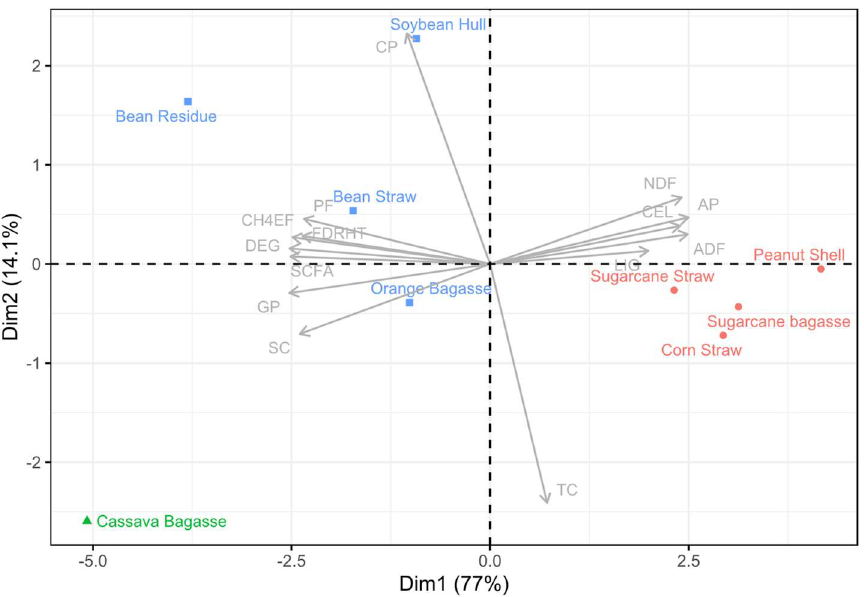
Figure 2. PCA showing the grouping and separation of the by-products based on chemical composition, in vitro degradability, and fermentative parameters. ADF: acid detergent fiber; AP: acetate/propionate ratio; CEL: cellulose; CH 4 EF: methane efficiency; CP: crude protein; DEG: degradability; FDRHT: gas production rate; GP: total gas produced; LIG: lignin; NDF: neutral detergent fiber; PF: partitioning factor; SC: soluble carbohydrates; SCFA: short-chain fa(cid:308)y acid; TC: total carbohydrate.